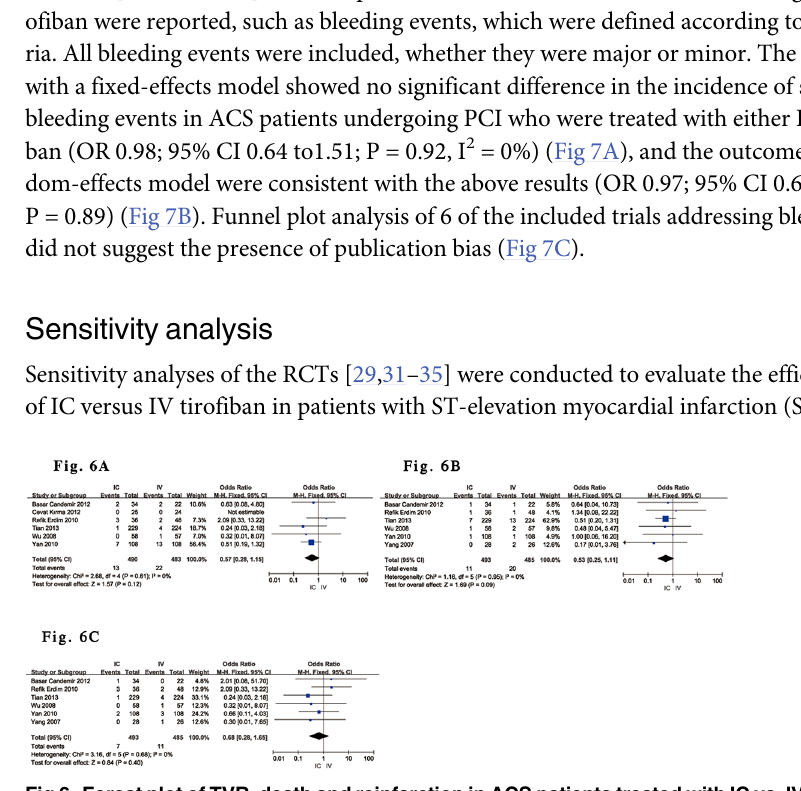
Fig 6. Forest plot of TVR, death and reinfarction in ACS patients treated with IC vs. IV administration of tirofiban. (A). Forest plot for TVR based on a fixed-effects model in ACS patients treated with IC vs. IV administration of tirofiban. (B). Forest plot for death based on a fixed-effects model in ACS patients treated with IC vs. IV administration of tirofiban. (C). Forest plot for reinfarction based on a fixed-effects model in ACS patients treated with IC vs. IV administration of